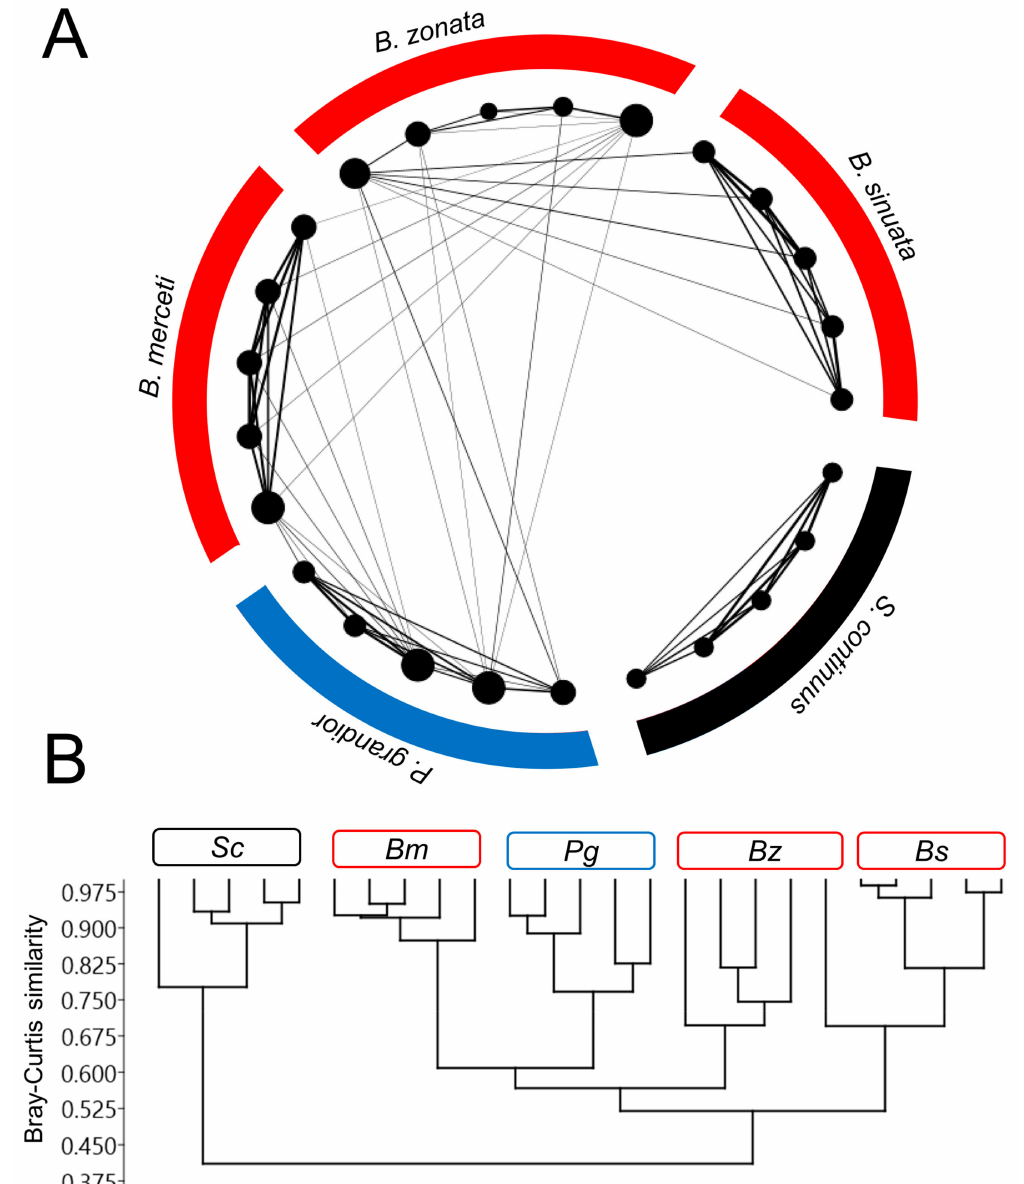
Figure 3. ( A ) Network plot based on Bray-Curtis distances showing the similarities among all individual CHC profiles of P. grandior , its Bembix hosts, and the non-host S. continuus . Only edges connecting individuals (i.e., nodes) with > 50% similarity in their CHC profiles are shown. The diameter of nodes is proportional to the number of edges connected to it, and the thickness of edges is proportional to the similarity. ( B ) Dendrogram based on the agglomerative cluster analysis (Bray-Curtis distances) of all individual CHC profiles of P. grandior , its Bembix hosts, and the non-host S. continuus . Bs = B. sinuata , Bz = B. zonata , Bm = B. merceti , Pg = P. grandior , Sc_S = S. continuus